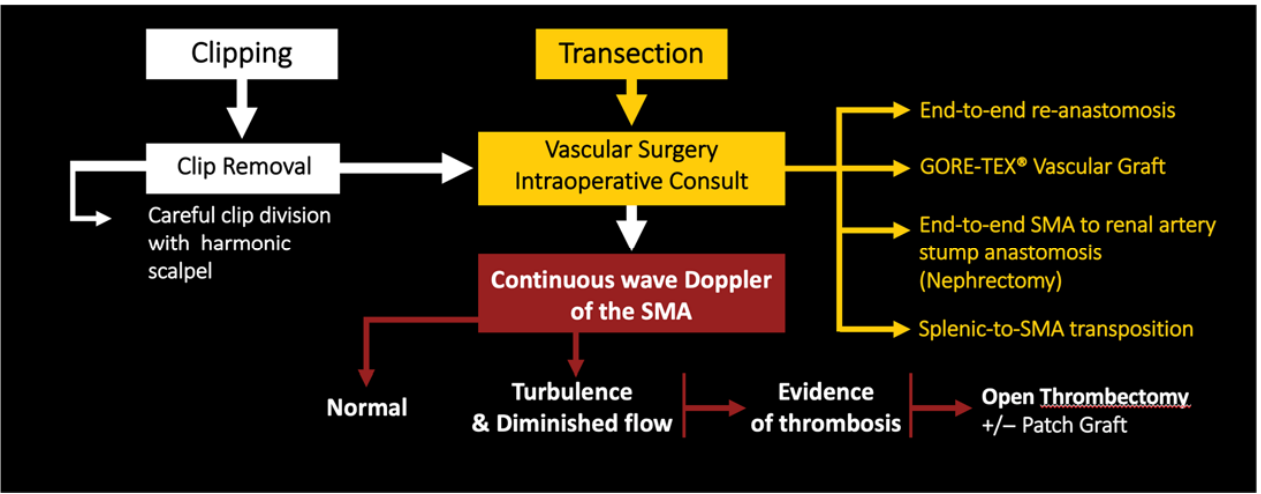
Figure 4 . Systematic workup algorithm management of SMA injury.